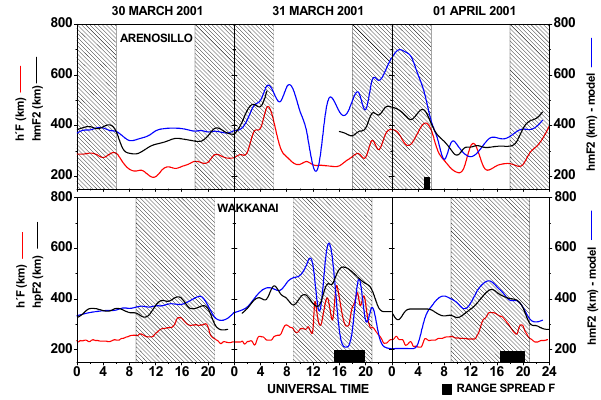
Figure 4a Fig. 4a. Same as in Fig. 2a, but for mid-latitude stations El Arenosillo and Wakkanai.